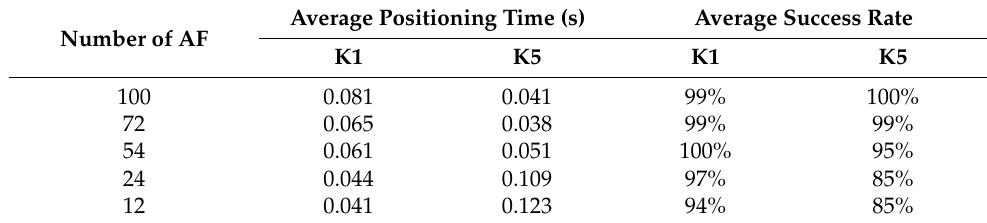
Table 16. Average positioning time and success rate of modes K1 and K5. Average Positioning Time (s) Average Success Rate Number of AF K1 K5 K1 K5 100 0.081 0.041 99% 100% 72 0.065 0.038 99% 99% 54 0.061 0.051 100% 95% 24 0.044 0.109 97% 85% 12 0.041 0.123 94% 85%